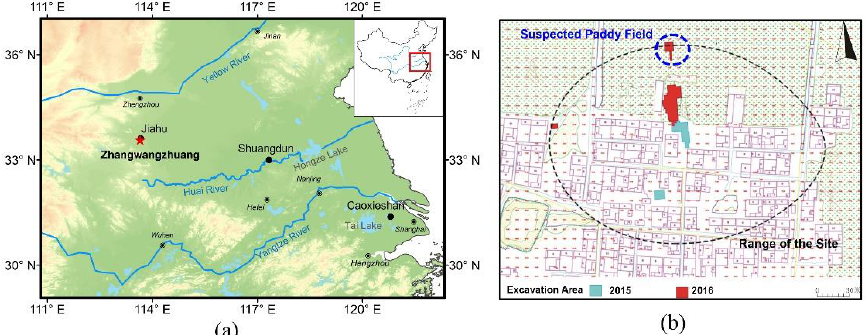
Figure 1. ( a ) Location of the Zhangwangzhuang site and other ancient paddy sites mentioned in this study; ( b ) and the excavation areas and suspected rice paddy at